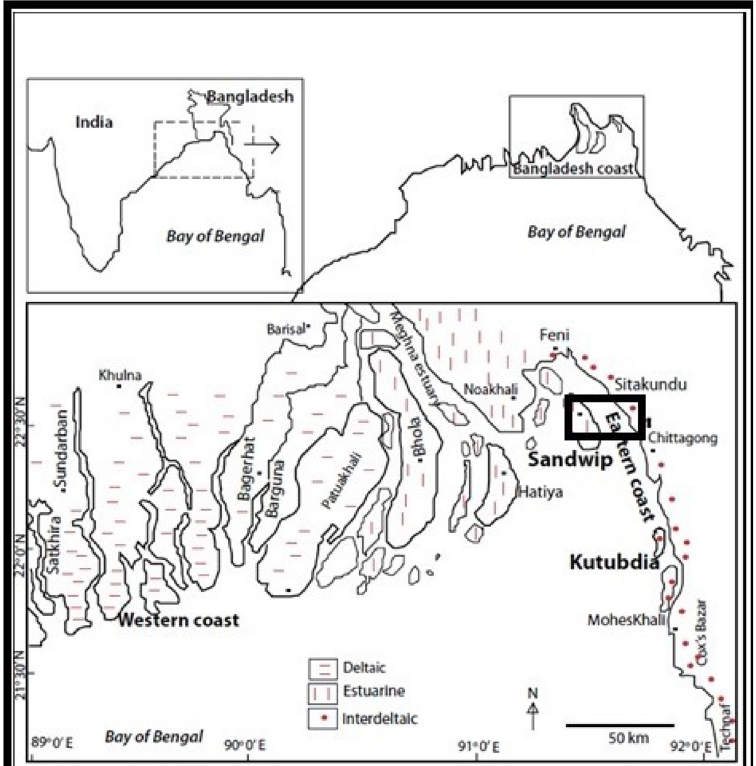
Figure 1. Location of Bangladesh coast and rectangular showing selected study